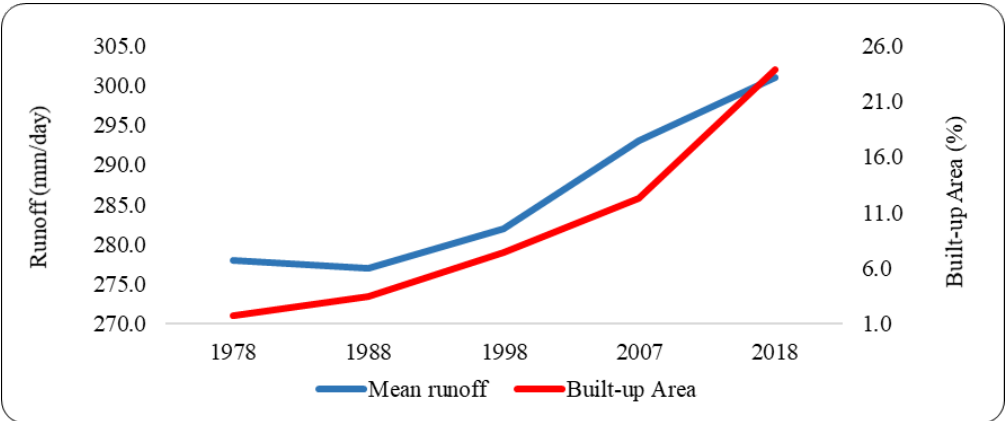
Figure 9. Relationship between built-up area and mean runoff during 1978–2018.